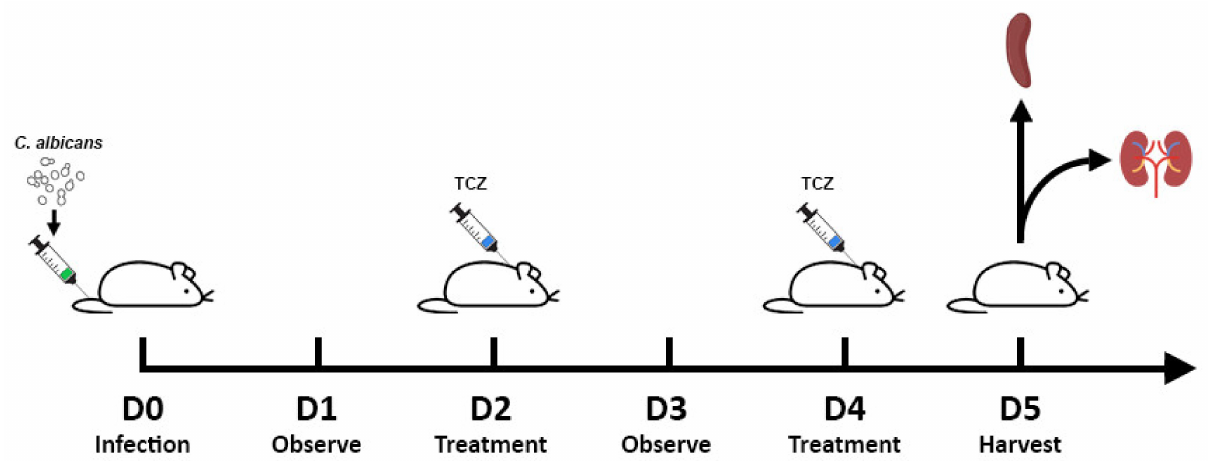
Figure 1. Disseminated candidiasis mice model. Schematic diagram of administration of C. albicans and tocilizumab. Mice were infected with C. albicans on D0, followed by treatment with either tocilizumab or saline on D2 and D4, and the study was terminated on D5. Spleens and kidneys were removed. Spleens were crushed and splenocytes were obtained for stimulation with the respective ligands. One set of the pair of kidneys were used for histological studies and the other for fungal load